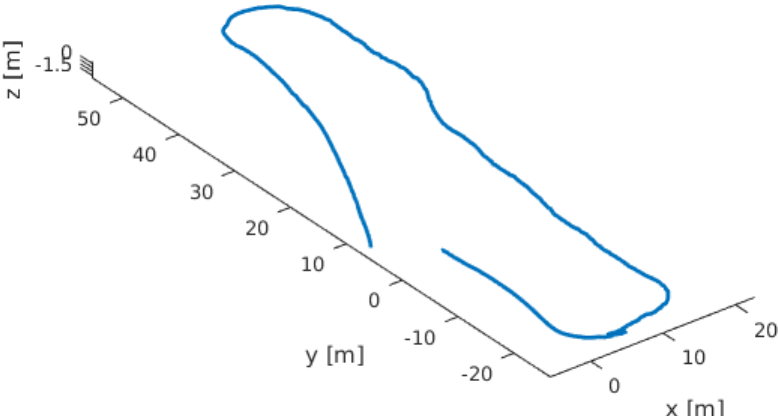
Figure 4. SICK scanner and the Chameleon positioning system mounted on a roof rack. The SICK scanner is facing forward with 9 degrees of declination, and the Bumblebee camera is facing sideways.